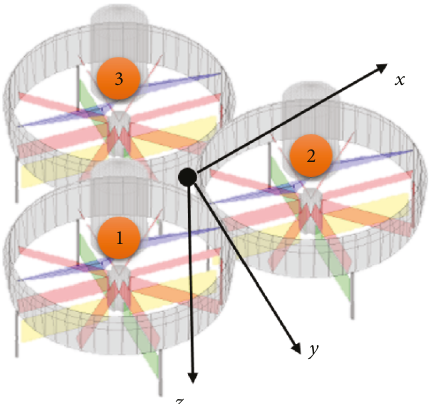
Figure 7: Simulation model consisting of three single modules.